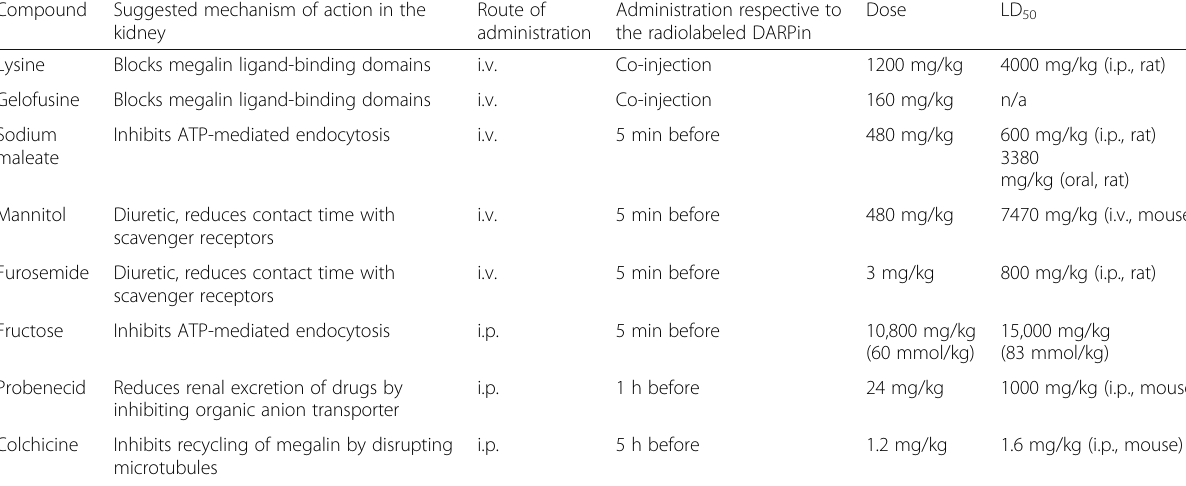
Table 1 List of compounds that were administered to mice before injections of radiolabeled DARPins Compound